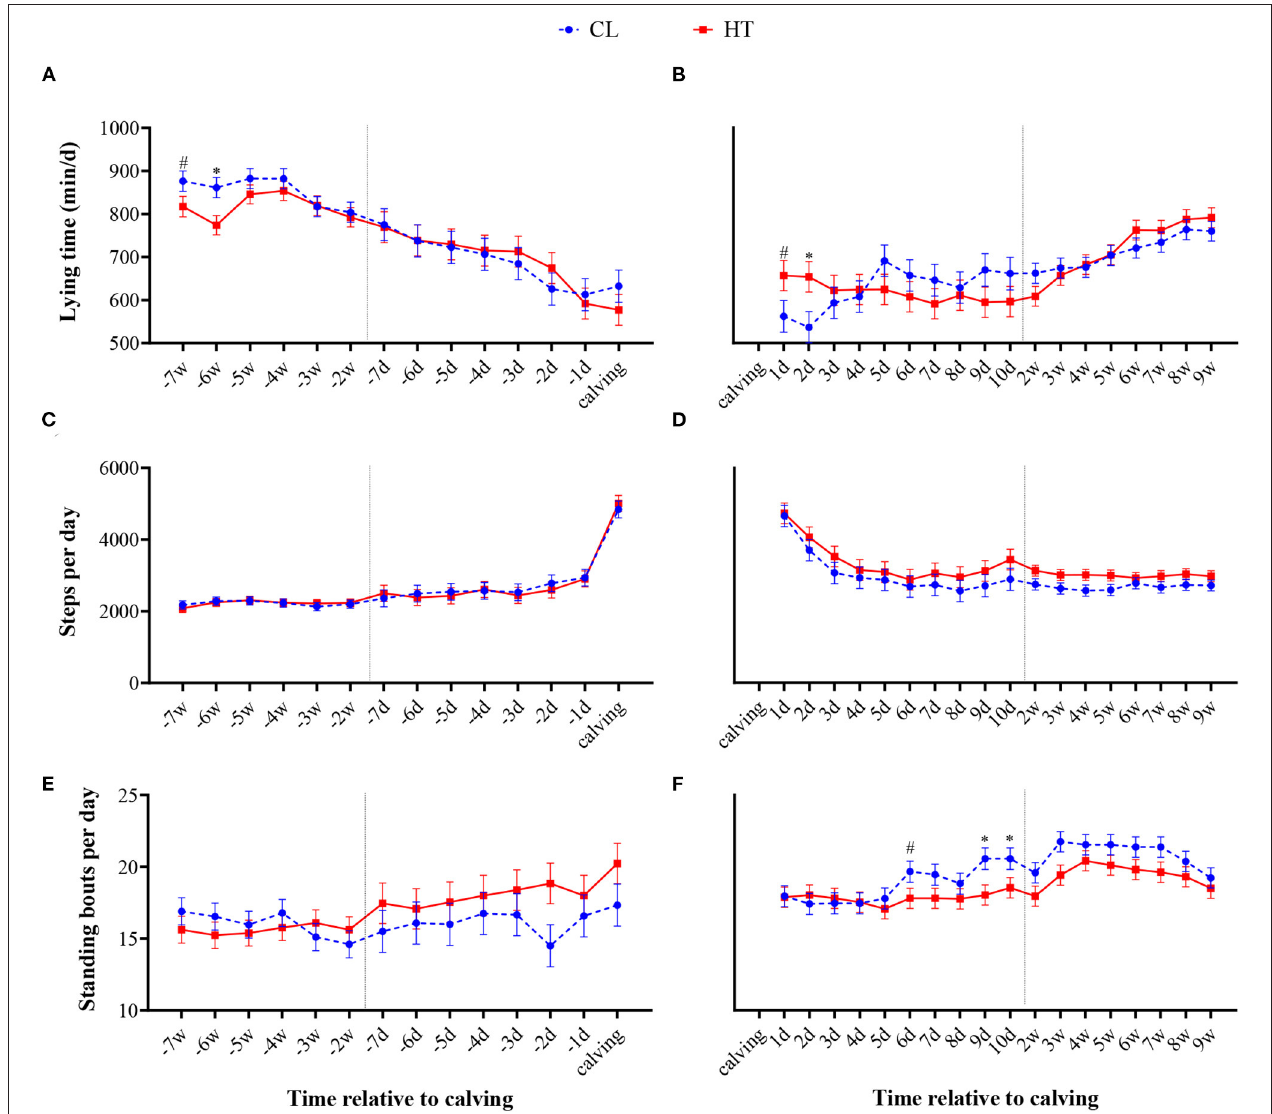
FIGURE 2 | Lying time (A,B) (min/d), number of steps (C,D) , and standing bouts [bout/d; (E,F) ] recorded from − 7 to 1 week before calving, from − 7 to 1 d before calving, from 1 to 10 d post calving, and from 2 to 9 weeks post calving in nulliparous Holstein heifer cooled by soakers and fans (CL, ) during the last 60 d of gestation and in heifers deprived of cooling (heat stress, HT, ). Animals of both treatments were cooled after parturition. Data are presented as LSM ± SEM and **indicates a treatment × time interaction P < 0.01, *indicates P < 0.05 and # indicates 0.10 ≤ P >